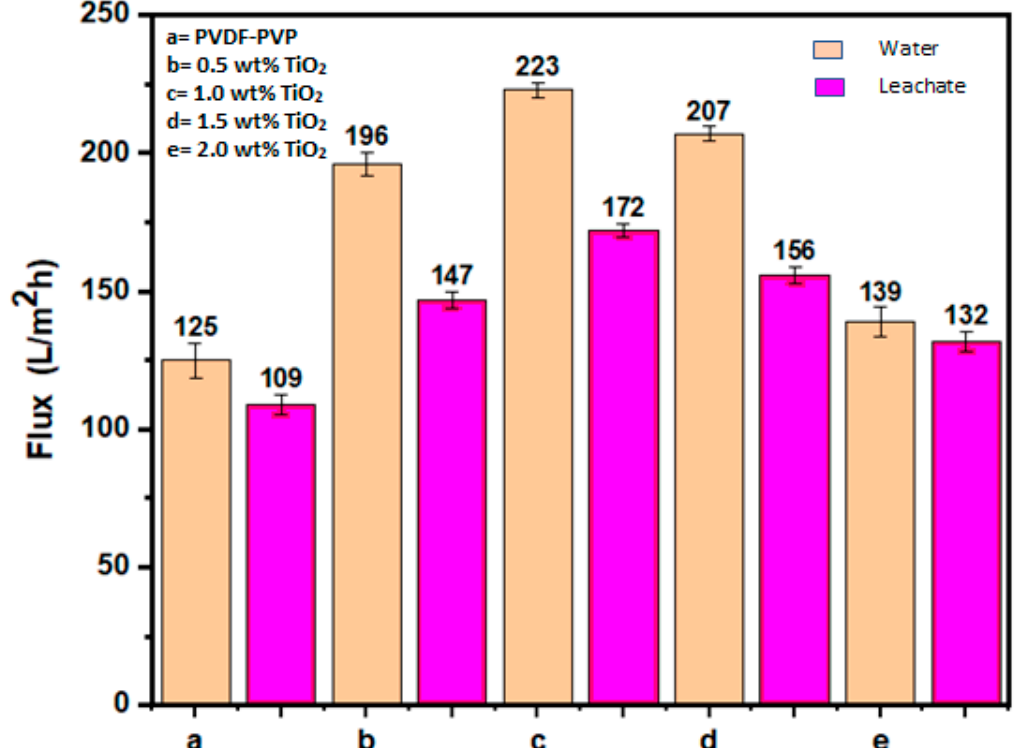
Figure 5. Flux of neat PVDF-PVP ( a ) and nano-hybrid membranes modified with TiO 2 ( b – e ).